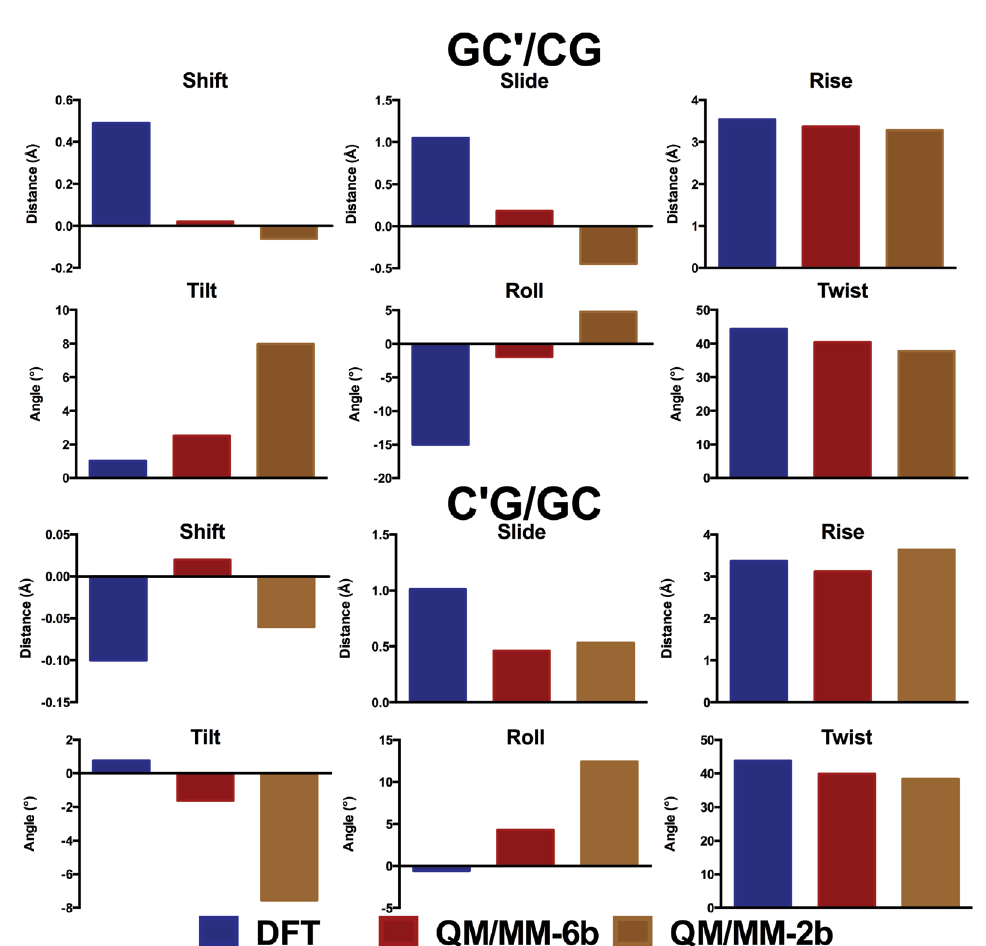
Figure 4. Comparison of QM/MM with DFT geometry for central GC and modifications thereof in d(GCG) (Å and °). The corresponding values are shown in Data file 3 and Data file